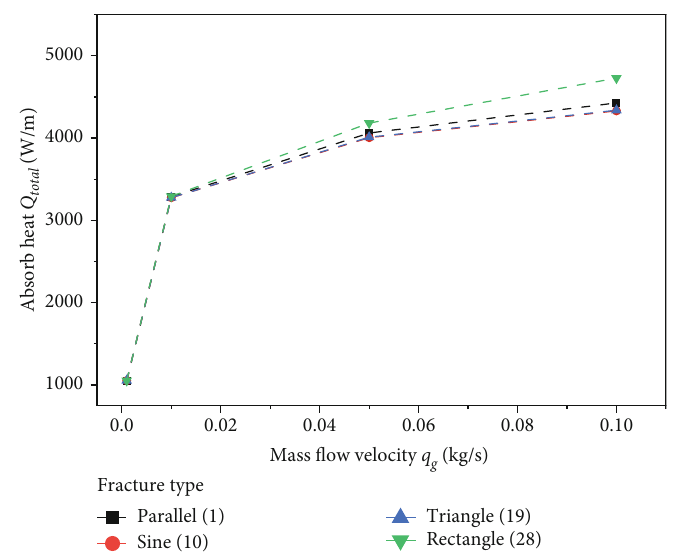
Figure 9: Relationship between fl ow rate and exchange heat.